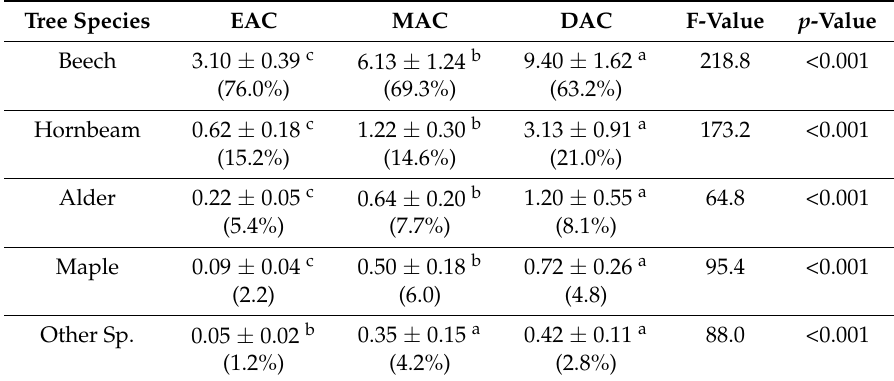
Table 7. Volume (average ± SD) of CWD (m 3 ha − 1 ) in tree species and accessibility classes and results of ANOVA and Tukey HSD tests 1